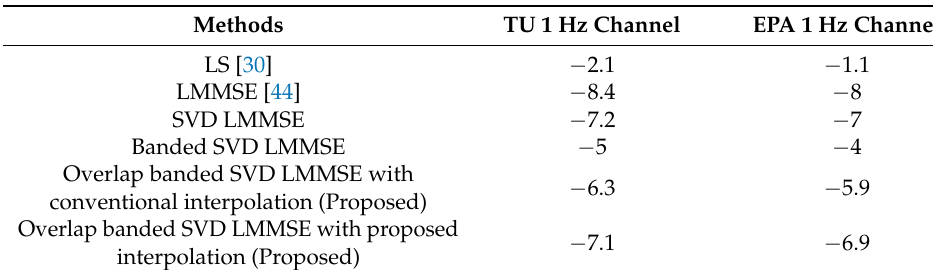
Figure 9. Mean square error (MSE) comparison of the proposed technique for conventional and proposed interpolation methods with traditional LMMSE and its other counterpart versions: ( a ) TU 1 Hz; ( b ) EPA 1 Hz.